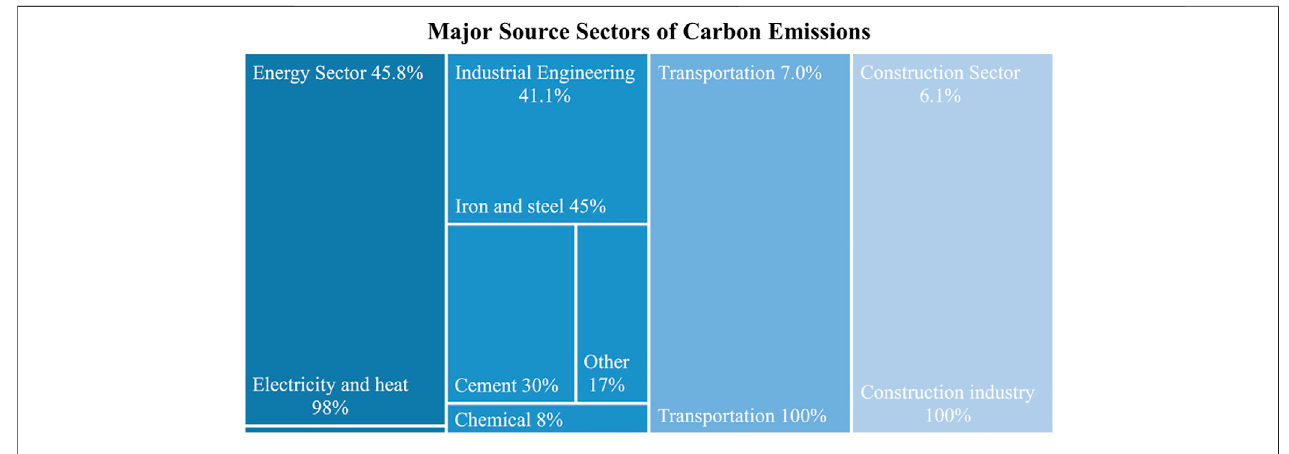
FIGURE 2 | Major source sectors of carbon emissions 3